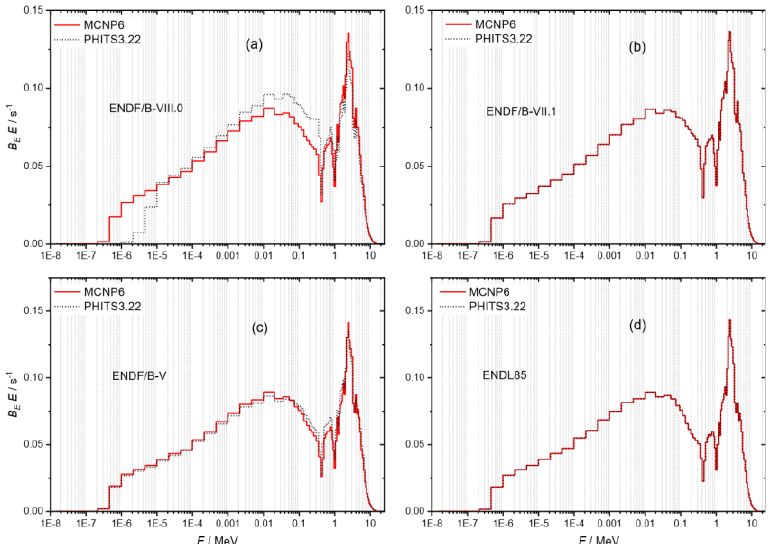
Fig. 3. Neutron spectra of the D 2 O- 252 Cf assembly at 100 cm distance calculated with MCNP6.1 and PHITS3.22 using four different data libraries (a) ENDF/B-VIII.0, (b) ENDF/B-VII.1, (c) ENDF/B-V and (d)